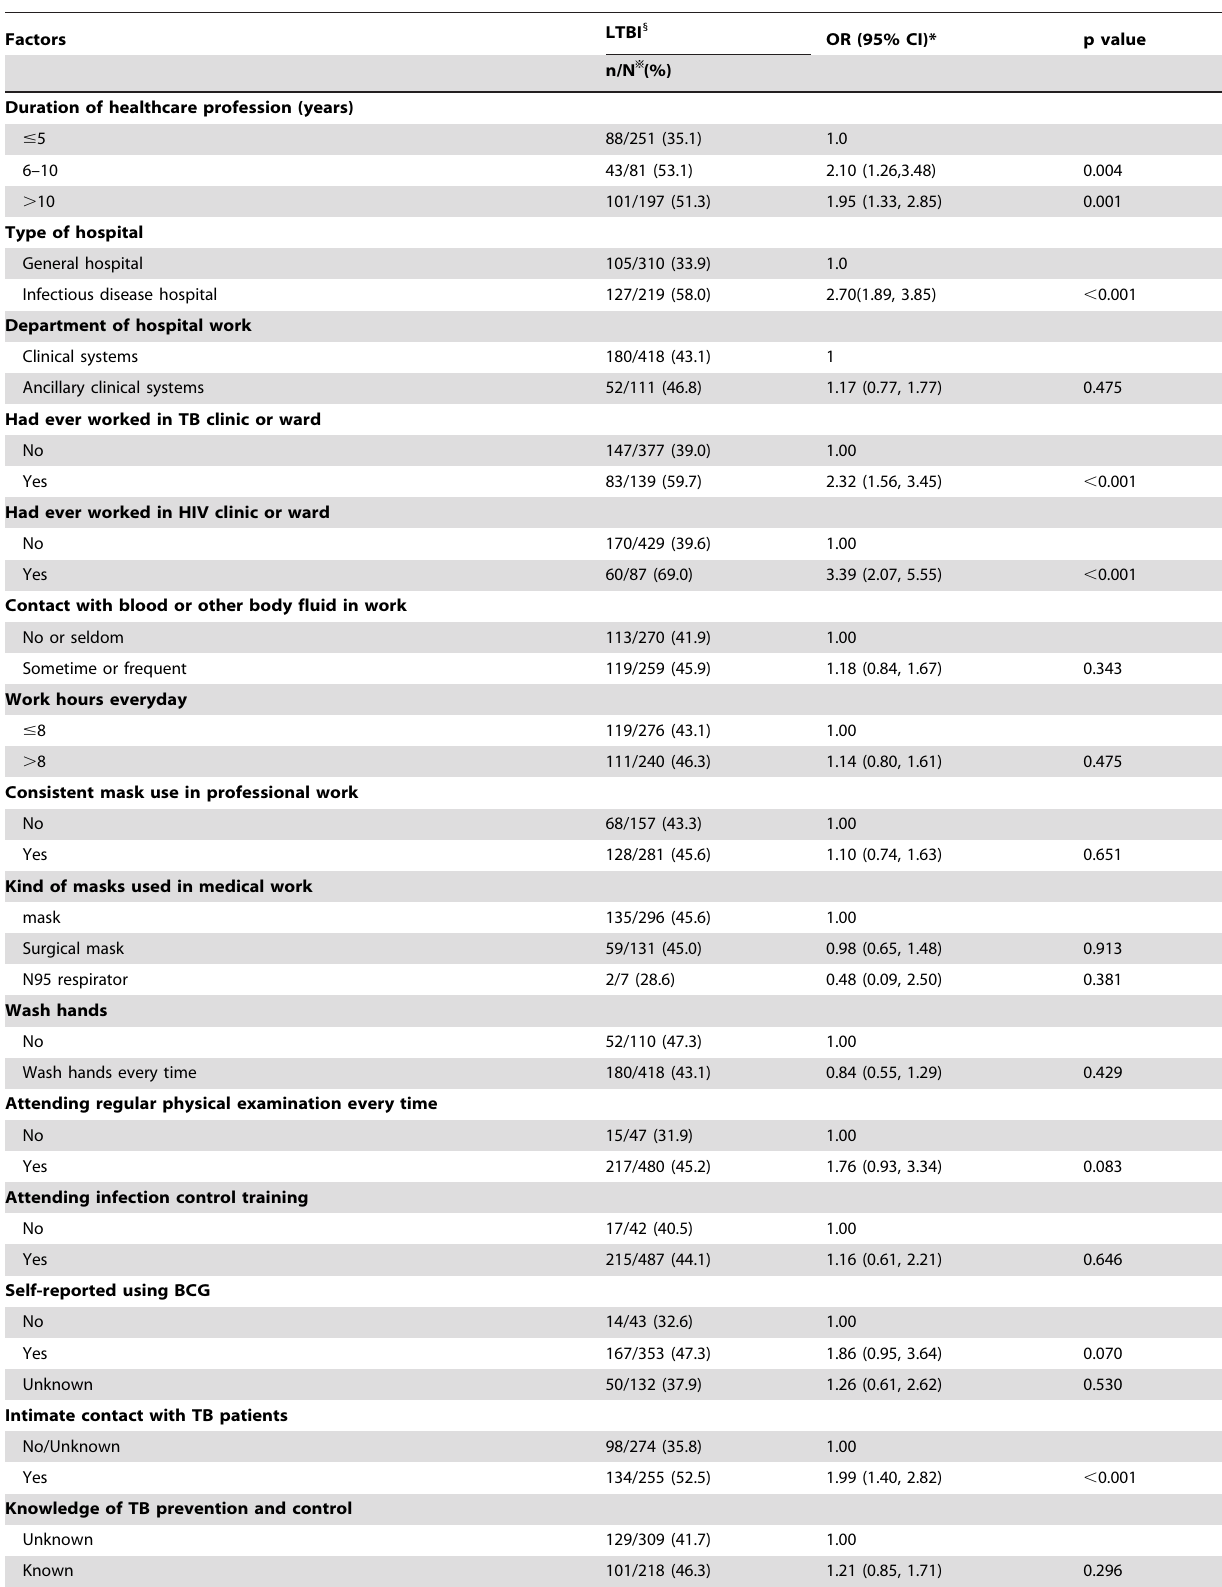
Table 2. Associations between medical works and professional protection strategy with LTBI 1